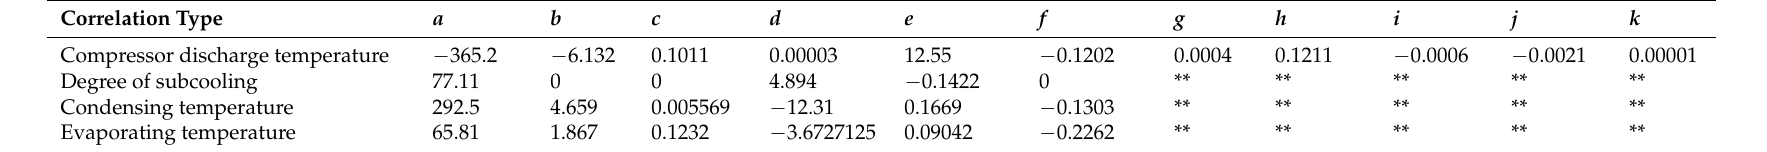
Table 5. Coefficients of refrigerant charge correlations in heating